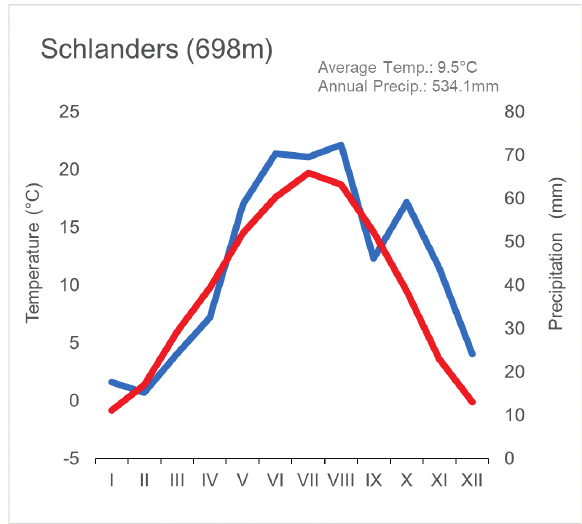
Figure 3. Climate diagram from Schlanders (1981–2010) based on data from the 3PCLIM-project (Source: ww- w.3pclim.eu). The red line shows the monthly mean temperature and the blue line the precipitation. Overall, there is an average temperature of 9.5°C and an annual precipitation rate of approximately 530